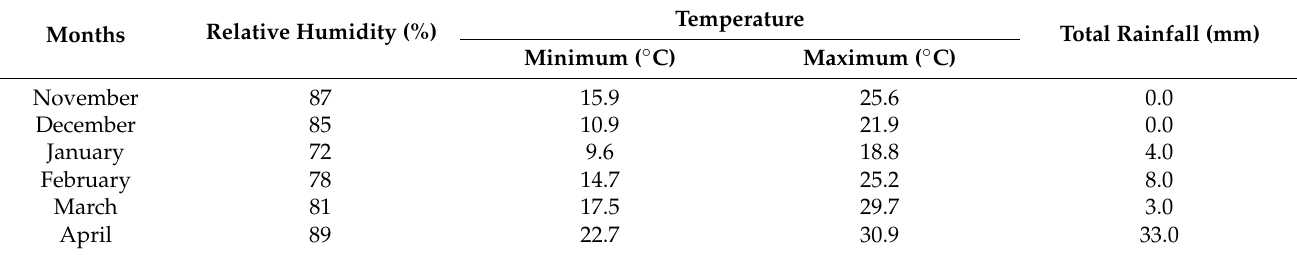
Table 3. Weather data during the growing period of wheat at the HSTU campus,